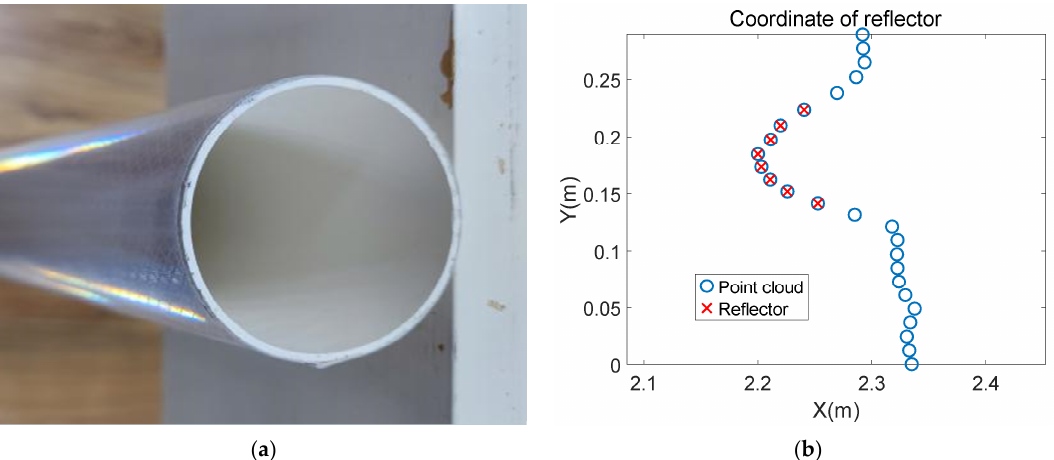
Figure 6. LiDAR scans the reflector placed close to a wall. ( a ) A vertical view of a reflector placed close to a wall. The cross section of the reflector is a circle and the cross section of the wall is a straight line. It can be seen from the placement that the circle is close to the line. ( b ) Schematic diagram of point clouds obtained by LiDAR scanning ( a ).